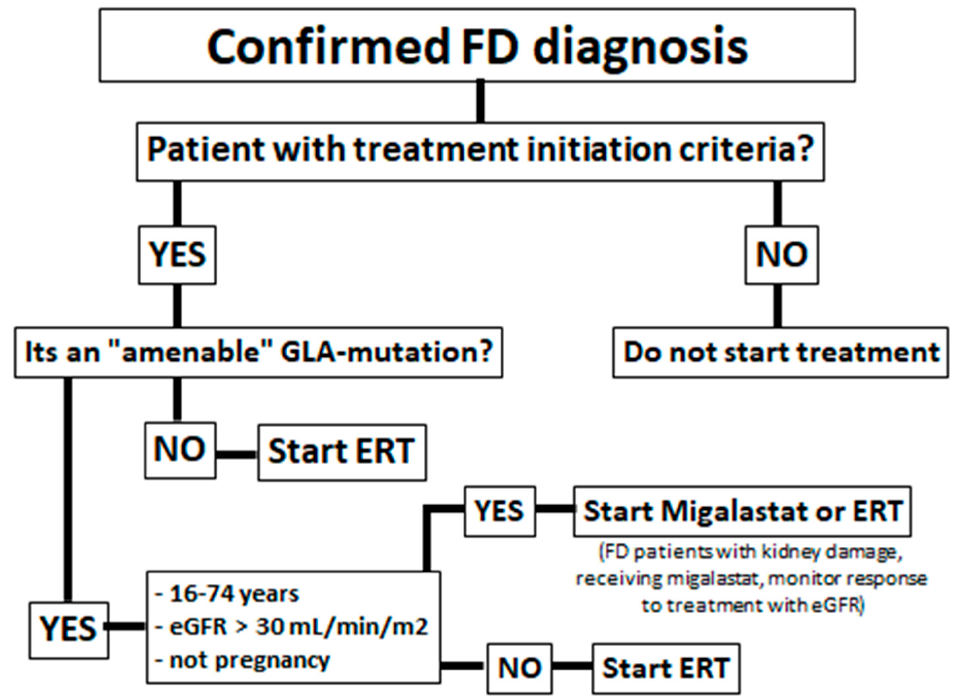
Figure 1. Algorithm for the indication of migalastat in Fabry disease patients. Figure 1 . Algorithm for the indication of migalastat in Fabry disease patients. Migalastat was initially identified as a competitive inhibitor of the α -GalA